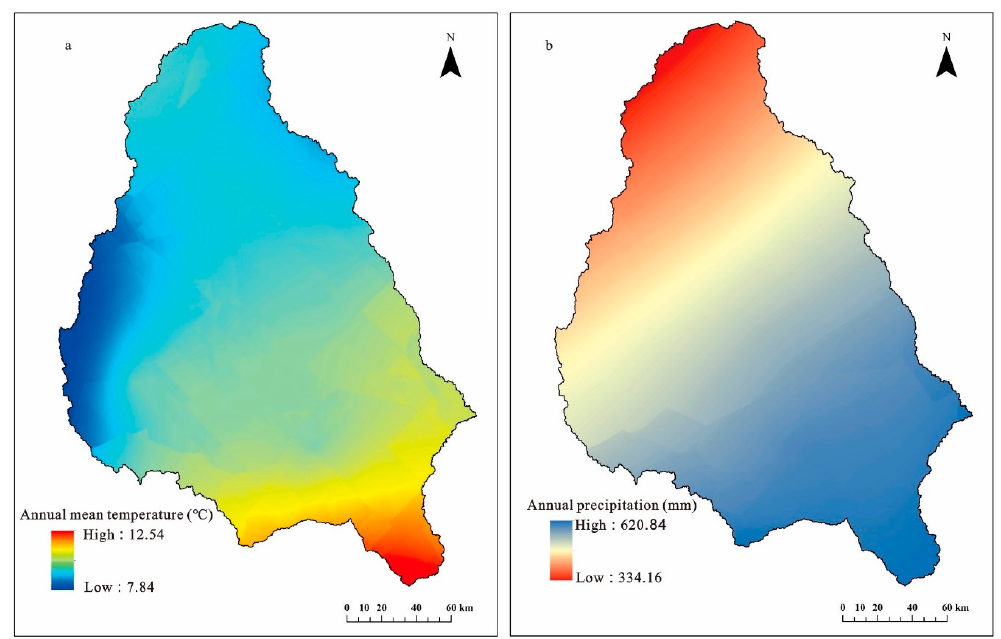
Figure 8. Spatial pattern of the annual mean temperature ( a ) and the annual precipitation ( b ) in the Jinghe River basin from 2000 to 2014.